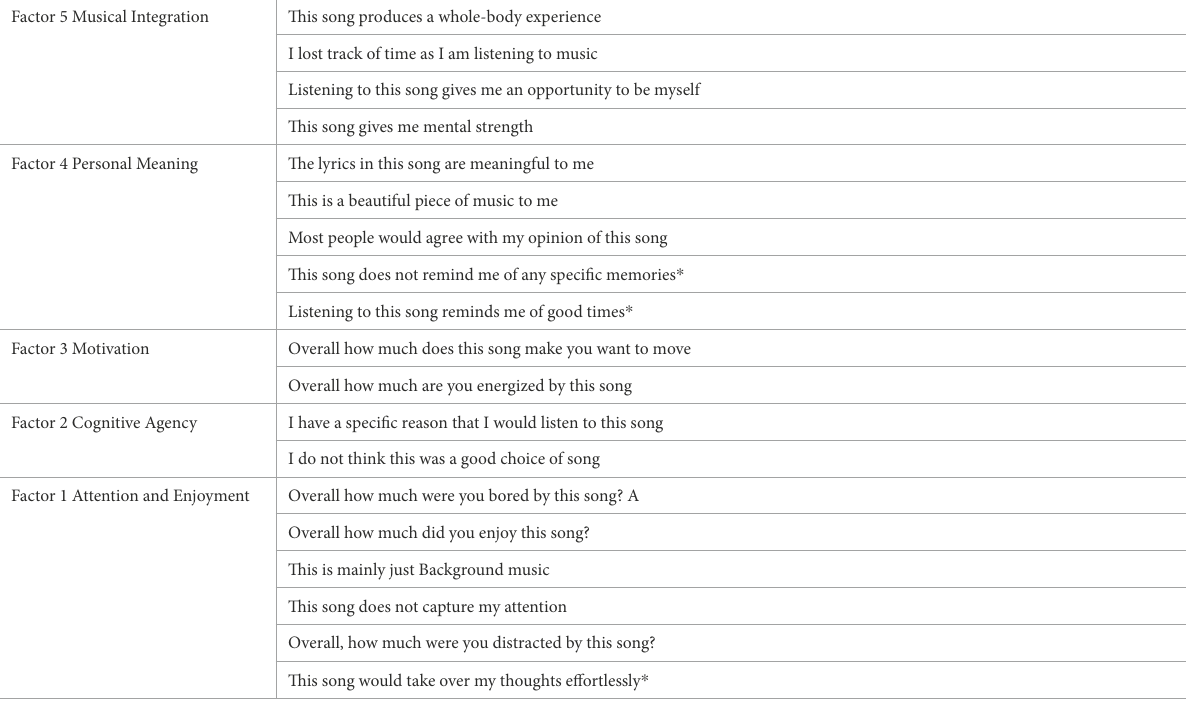
TABLE 1 Initial 19 items included in cognitive vitality